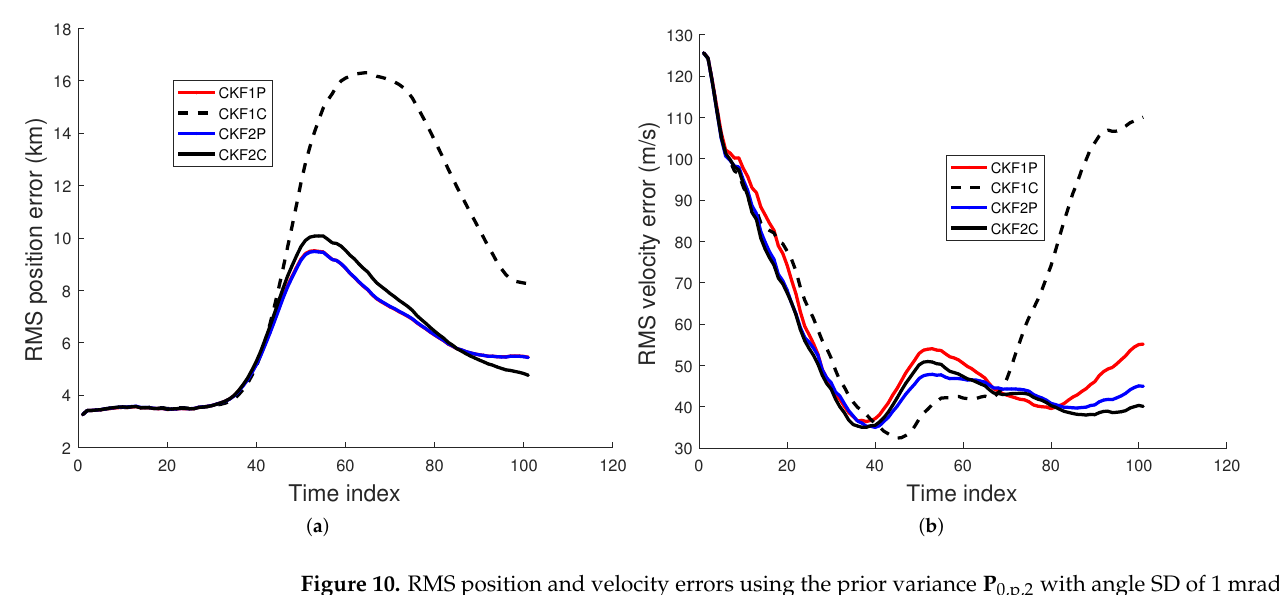
Figure 10. RMS position and velocity errors using the prior variance P 0,p,2 with angle SD of 1 mrad. ( a ) RMS position error, ( b ) RMS velocity error.